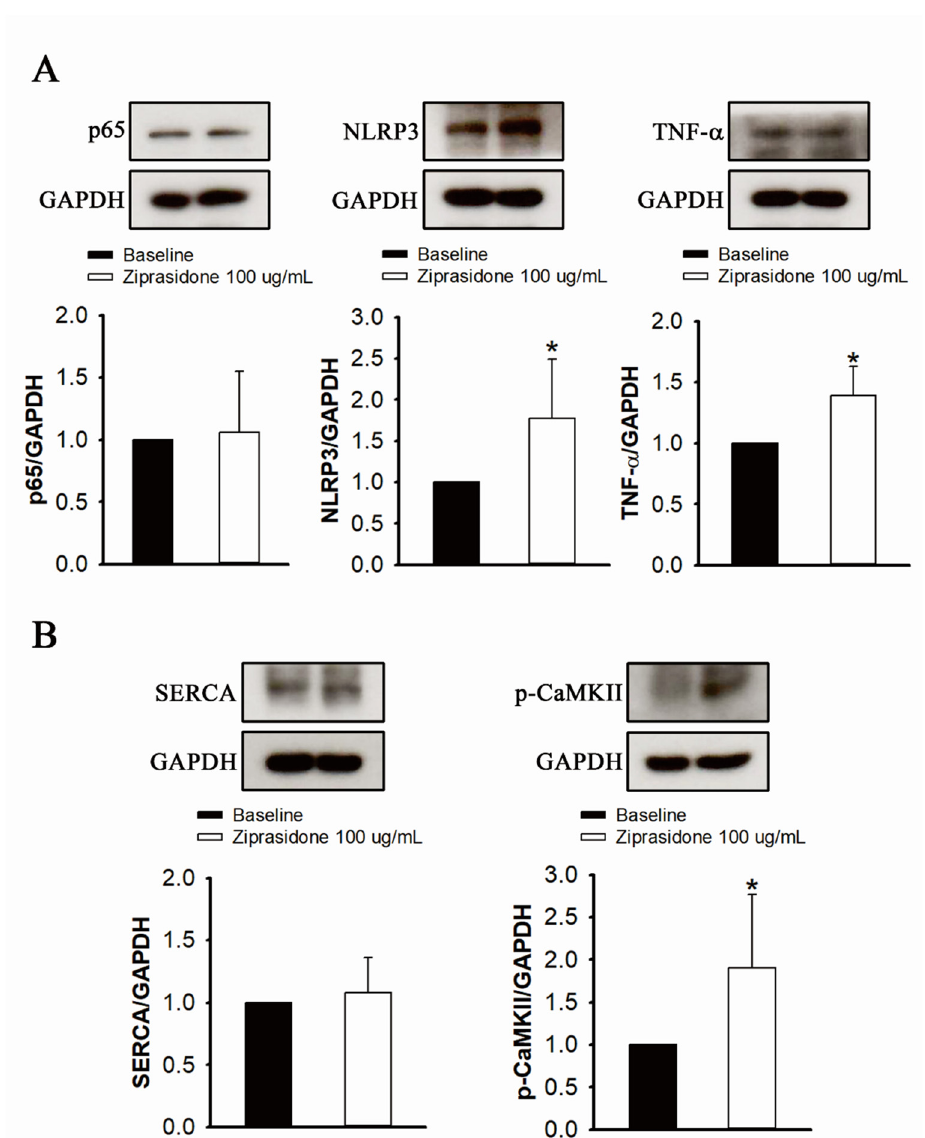
Figure 6. Proinflammatory cytokine and inflammasome markers, and Ca 2+ regulatory proteins, in control and ziprasidone-treated atrial myocytes. ( A ): Representative immunoblot (upper section) and normalized densitometric p65, NLRP3 and TNF- α protein levels in control and ziprasidone-treated atrial myocytes. ( B ): Representative immunoblot (upper section) and normalized densitometric SERCA2a and phosphorylated CaMKII protein levels in control and ziprasidone-treated atrial myocytes. GAPDH was used as an internal control (control group n = 6 and ziprasidone group n = 6; * p < 0.05).